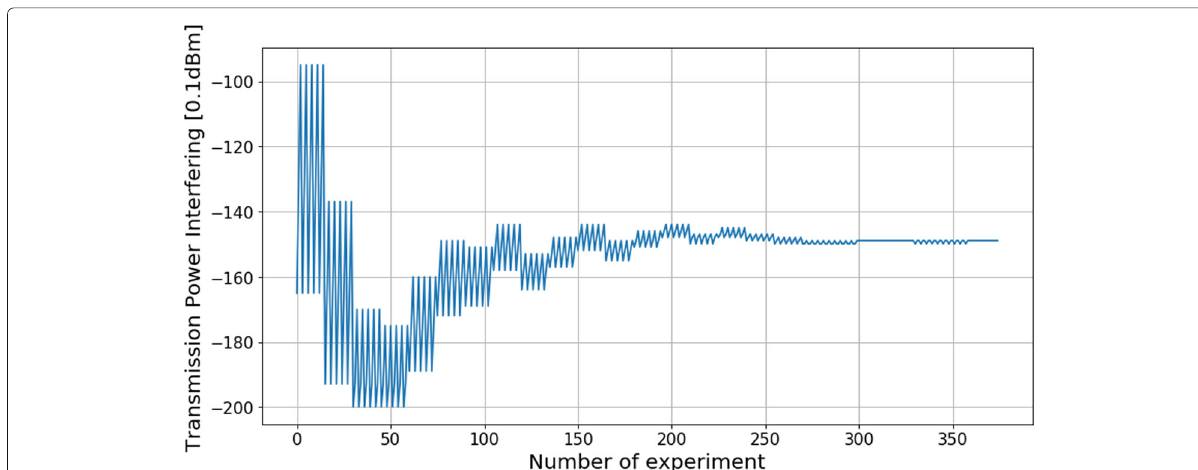
Fig. 9 Interfering cell transmission power adjustment